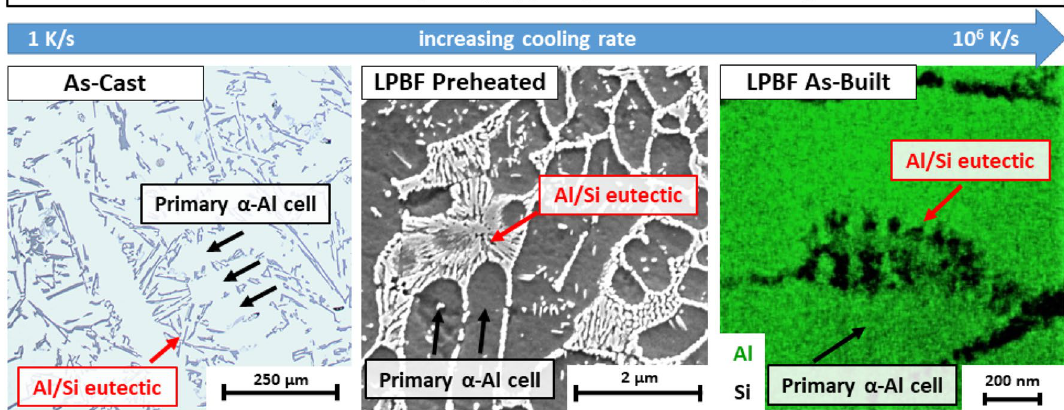
Figure 9. Different AlSi10Mg microstructures covering a broad solidification spectrum with cooling rates ranging from 1 K/s to 10 6 K/s: As-cast (left), LPBF-processed with baseplate preheating at 200 °C (PH) (middle), LPBF As-built (AB) (right). The microstructural images indicate the microstructural scale effect and the observation of a repetitive microstructural pattern, as indicated by the arrows.